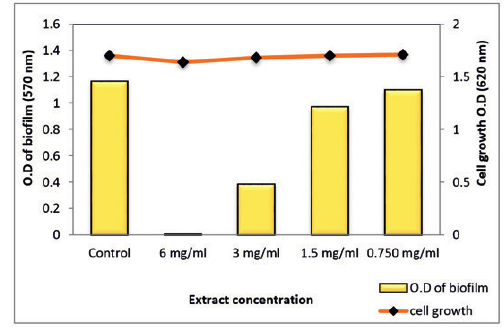
Fig. 12. Effect of sub-MIC of Z. spina-christi total extract on biofilm formation of MDR- P.